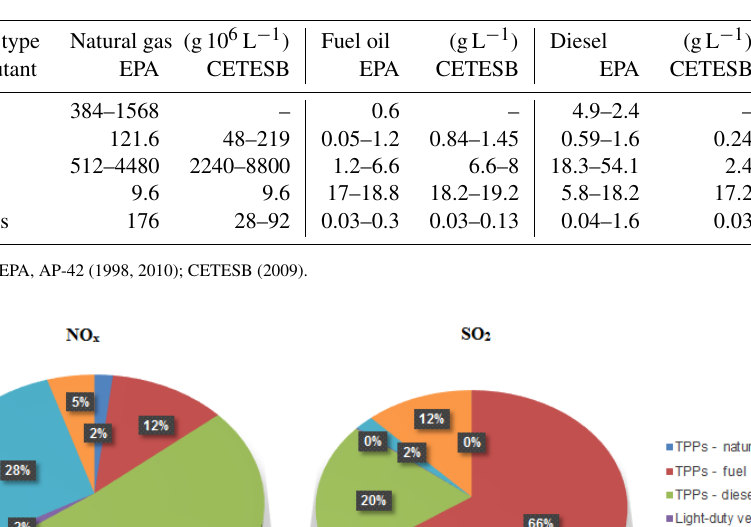
Table 3. Emission factors of TPPs per fuel type.